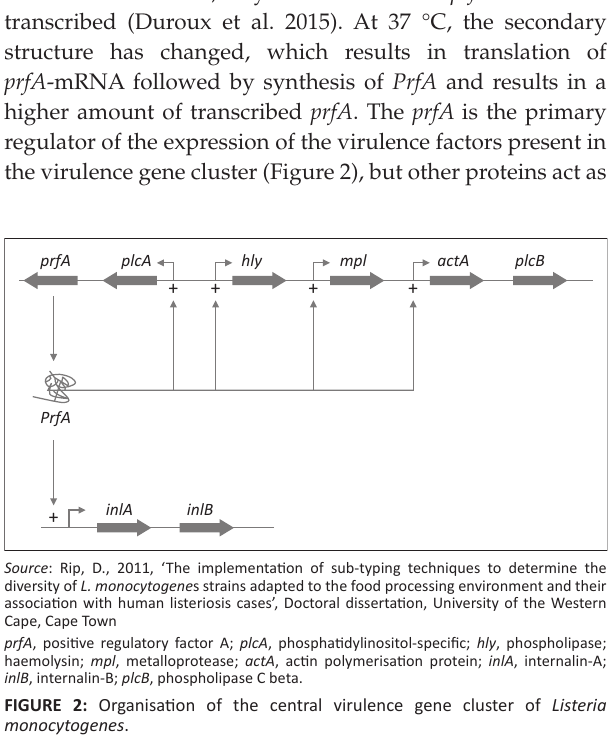
FIGURE 2: Organisation of the central virulence gene cluster of Listeria monocytogenes